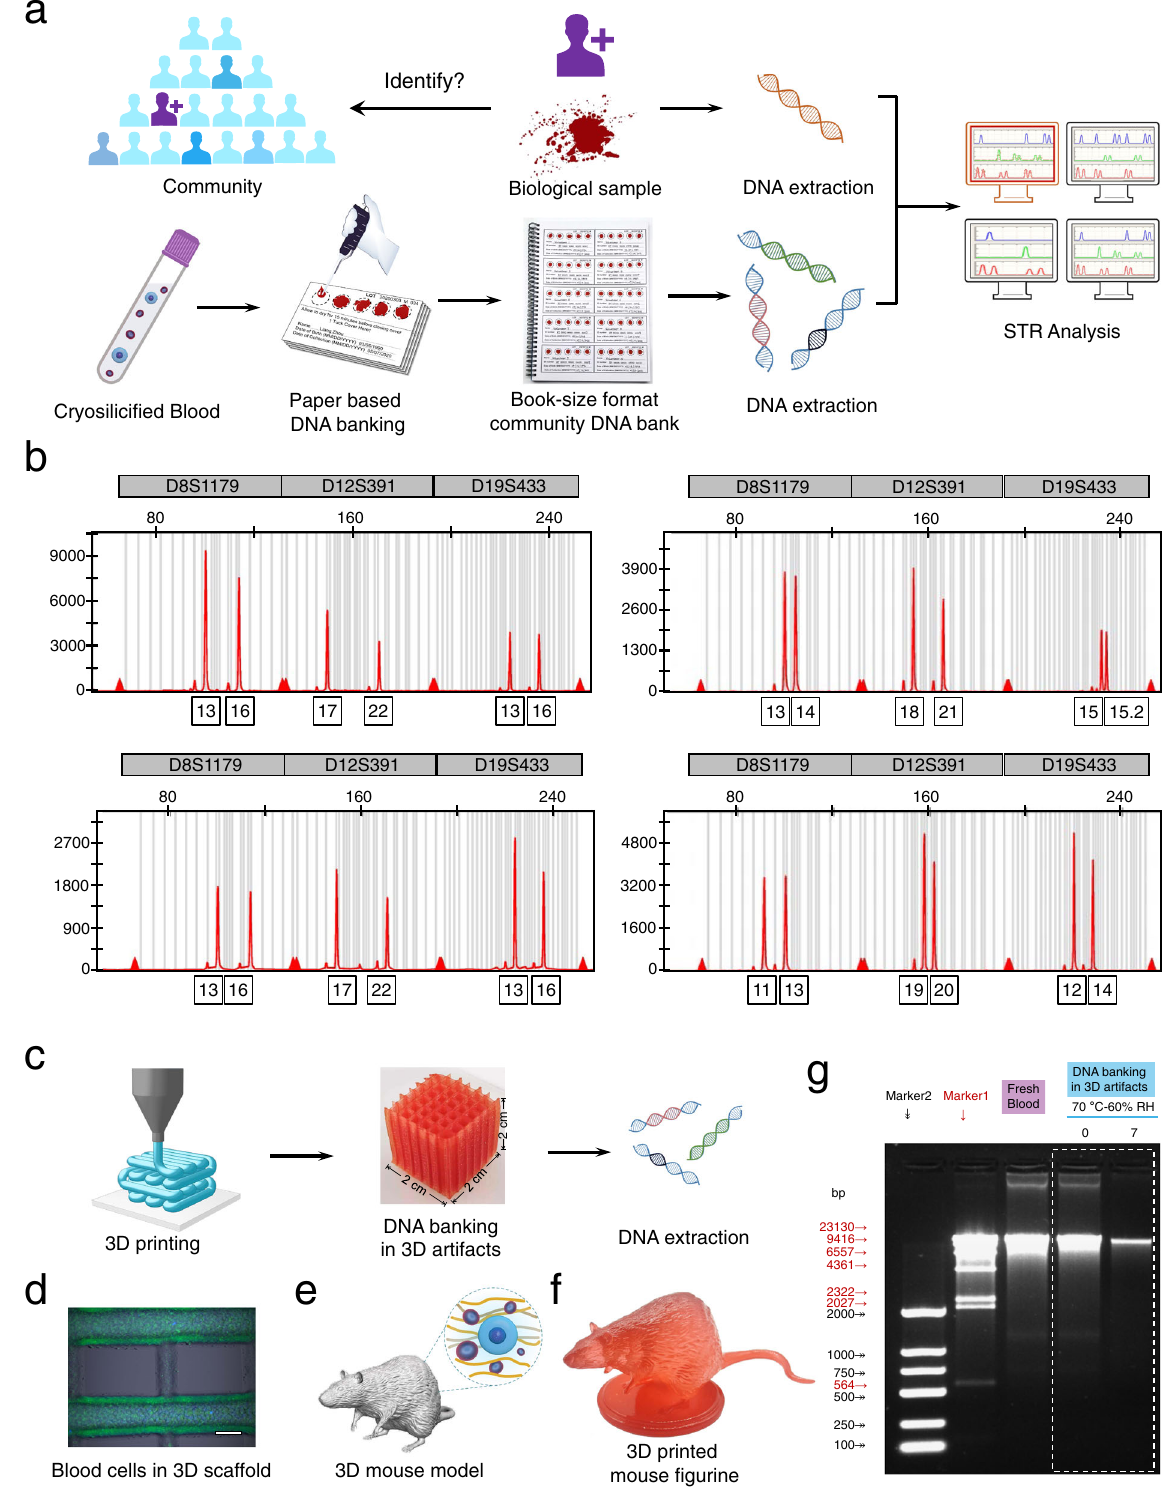
Fig. 6 | Construction of whole blood DNA banking with paper-based cards or 3D-printed artifacts. a Schematic representation of the preparation of paper- based whole blood genomic DNA banking and its application for forensic identi- fi cation. b STR analysis of DNA extracted from fresh blood samples and paper- based whole blood DNA bank after aging for 28 days at 70°C and 60% RH. c Schematic representation of the fabrication of whole blood genomic DNA banking with 3D-printed artifacts (middle, scale bars=2cm) and on-demanded DNAextraction. d Microscopy images of cryosilici fi ed leukocytes and erythrocytes